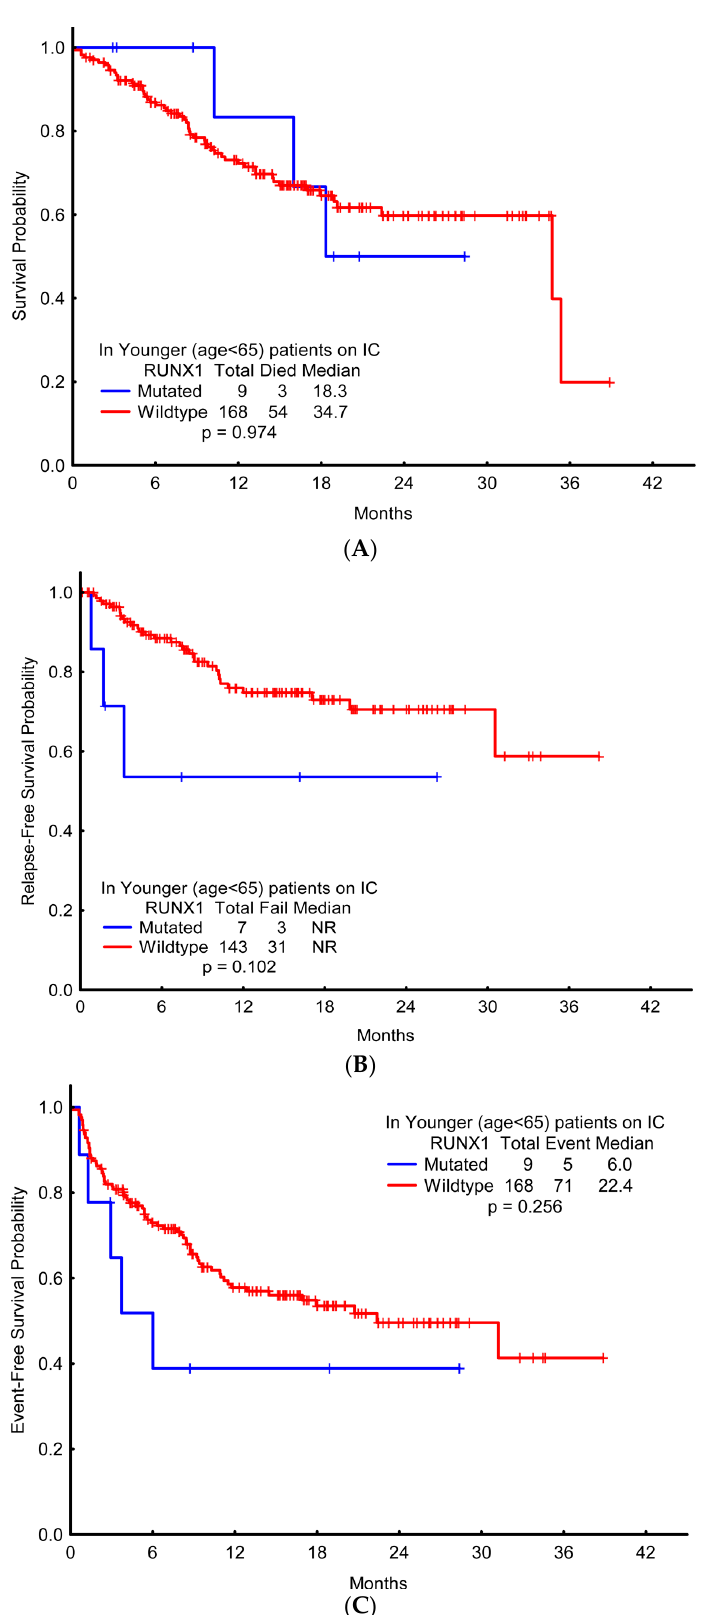
Figure 4. Survival probabilities among patients aged below 65 years who received induction with chemotherapy, compared with the presence or absence of RUNX1 mutation. ( A ) Overall survival; ( B ) Relapse-free survival; ( C ) Event-free survival.